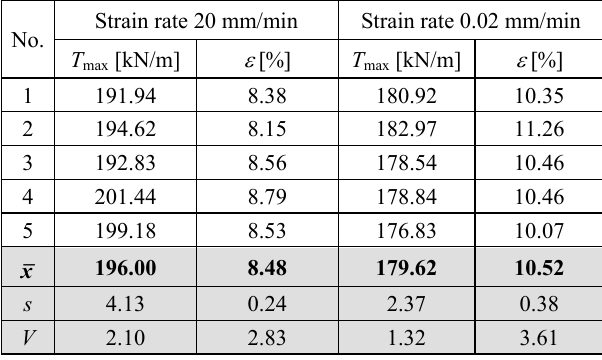
Table 1. Laboratory test results